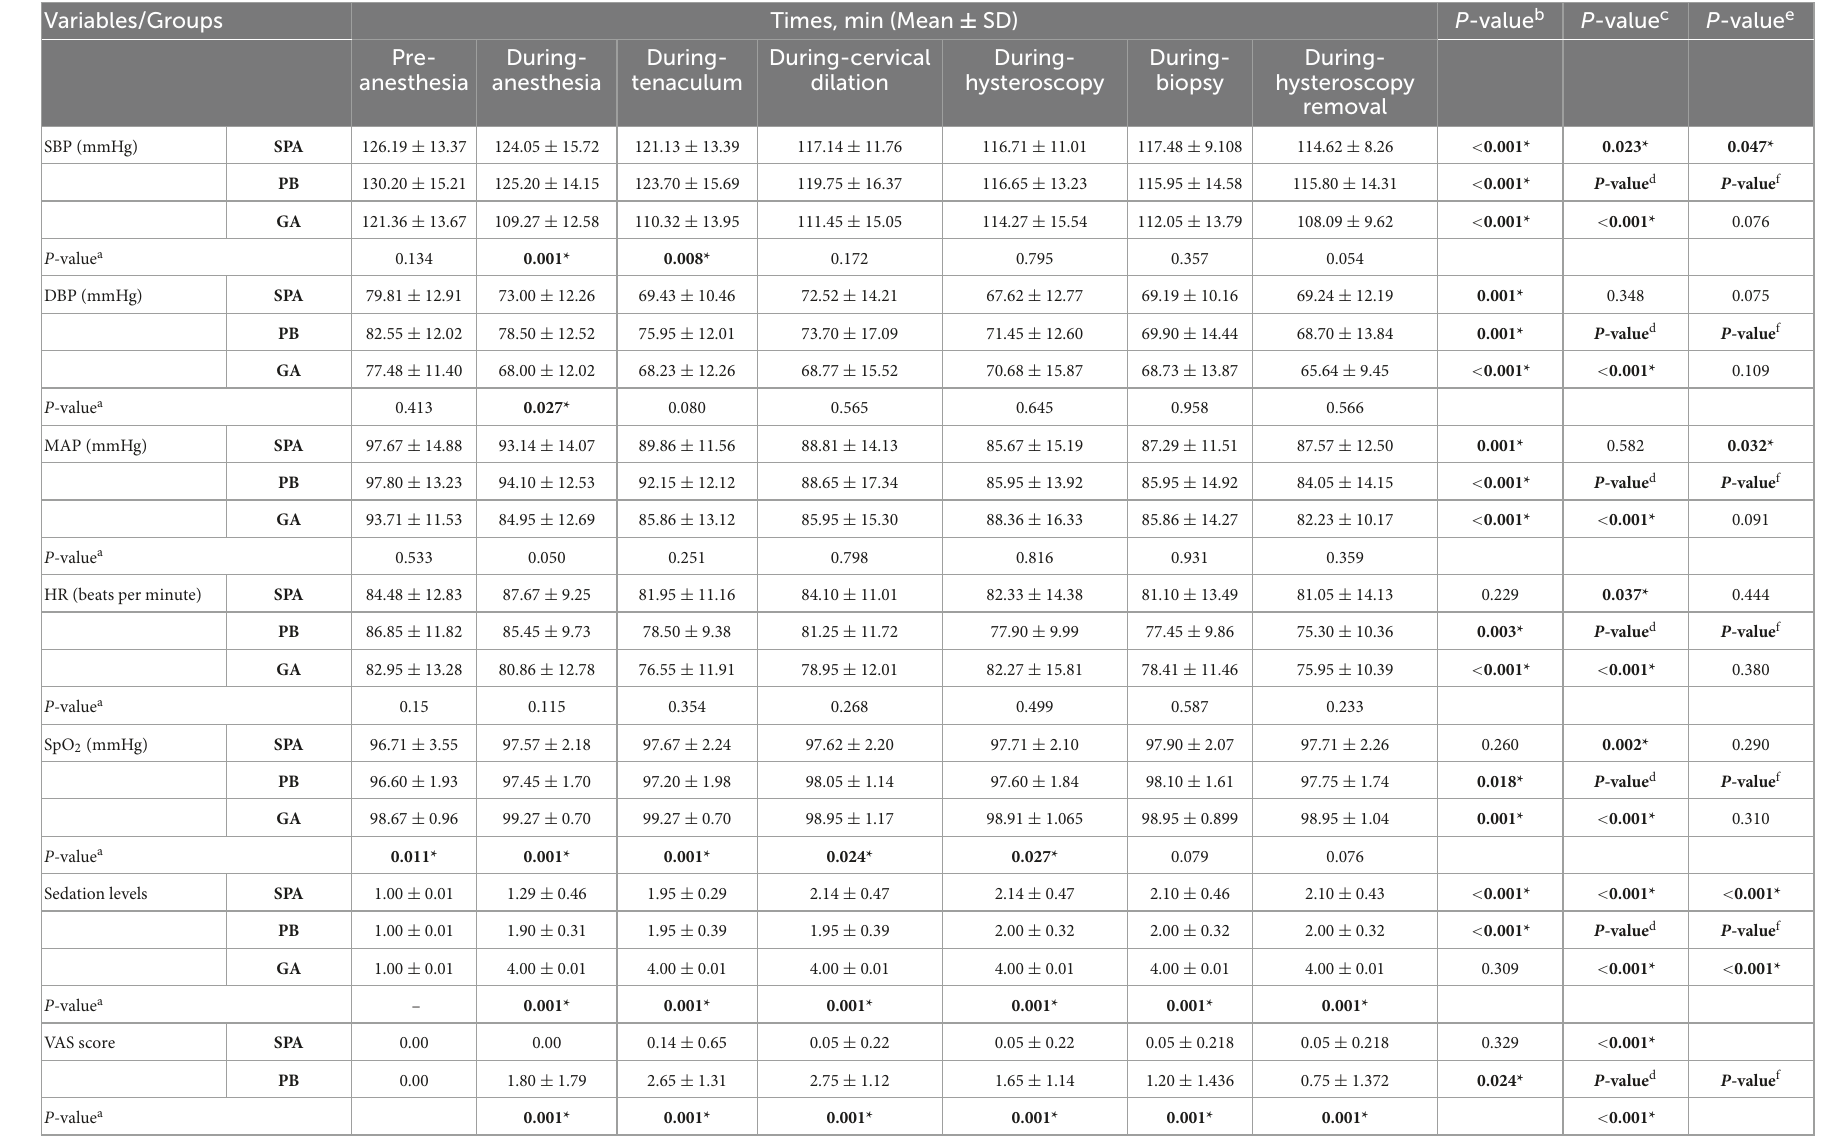
TABLE 2 Comparison of hemodynamic parameters, sedation level and VAS scores at different times between three groups of study.